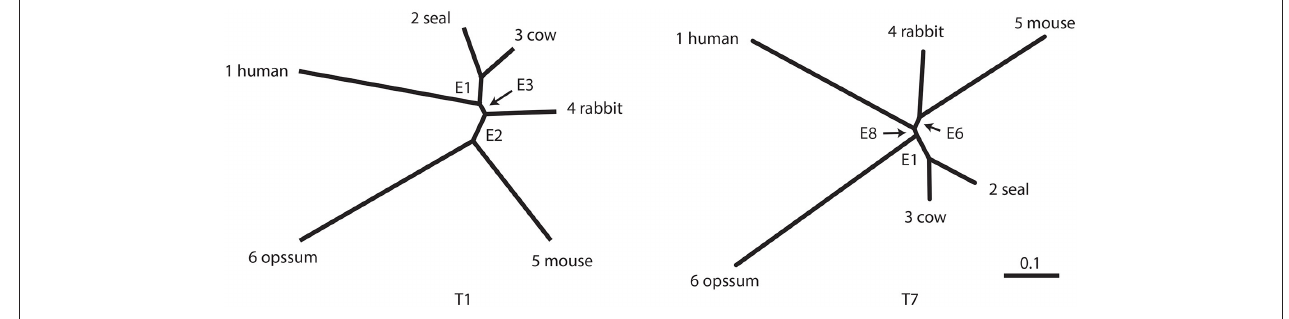
FIGURE 2 | Examples of two unrooted trees T1 and T7. Branch lengths represent ML estimates of parameters (expected number of substitutions per site). T1 includes edges E1, E2, and E3 and T7 includes E1, E6, and E8.